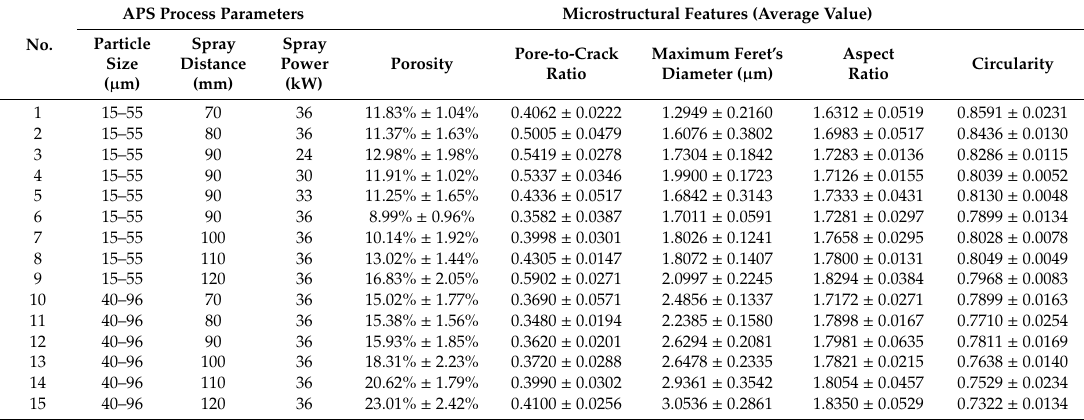
Table 3. Database for the training, validation, and test of the cuckoo search–support vector machine (CS-SVM) model.